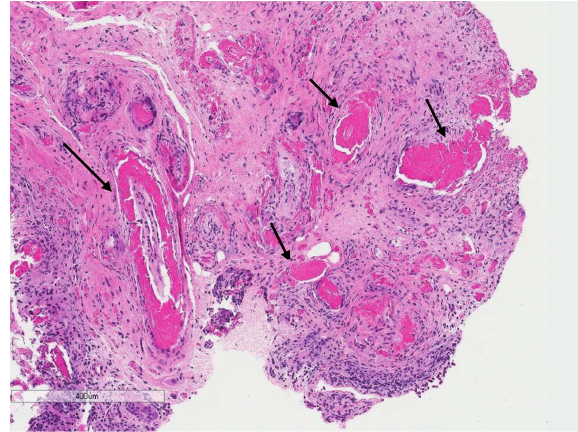
Figure 3 – Hematoxylin and Eosin (H&E) stain - Bladder biopsy: deposits of eosinofi lic material in the lamina propria (arrows).